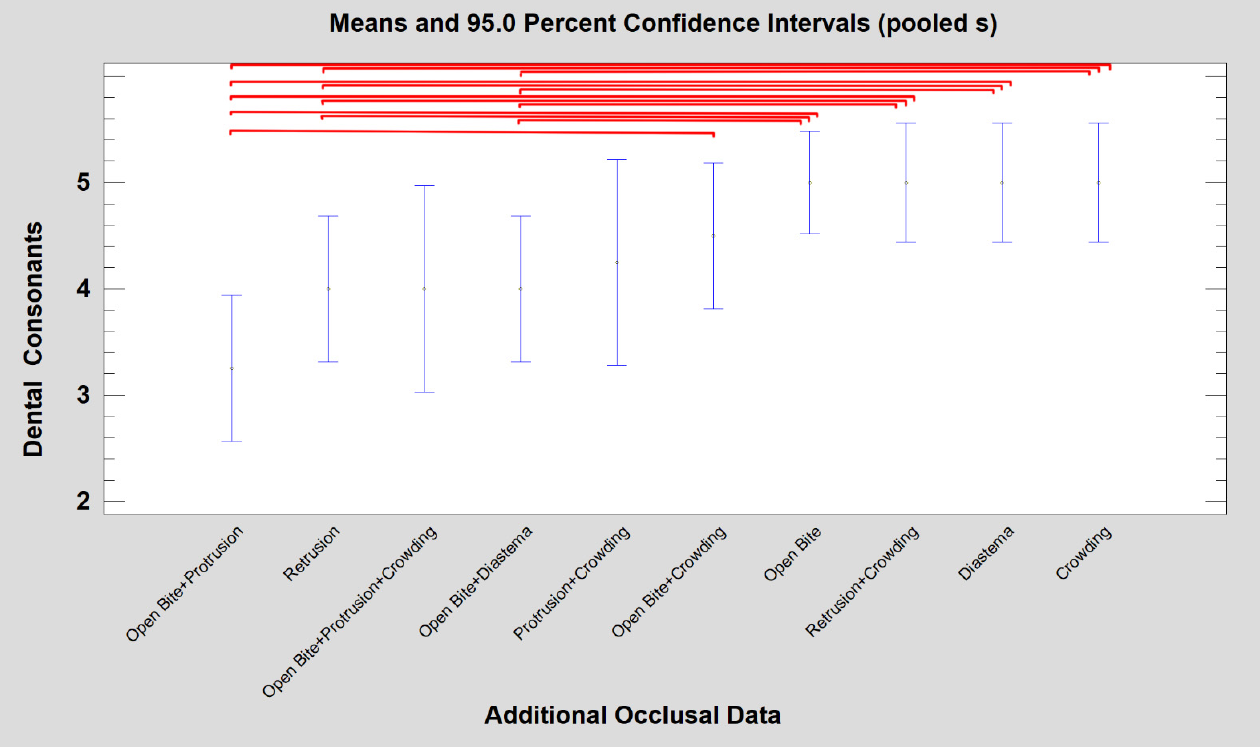
Figure 2. Final dental consonant pronunciation results in patients treated multimodally (higher scores, better speech). Quality of speech depends on specific dental positioning. These pairs show statistically significant differences at the 95.0% confidence level: Open Bite + Protrusion vs. Open Bite + Crowding, Open Bite + Protrusion vs. Open Bite, Open Bite + Protrusion vs. Retrusion + Crowding, Open Bite + Protrusion vs. Diastema, Open Bite + Protrusion vs. Crowding, Retrusion vs. Open Bite, Retrusion vs. Retrusion + Crowding, Retrusion vs. Diastema, Retrusion vs. Crowding, Open Bite + Diastema vs. Open Bite, Open Bite + Diastema vs. Retrusion + Crowding, Open Bite + Diastema vs. Diastema, and Open Bite + Diastema vs. Crowding ( p < 0.05). Red brackets indicate statistically significant differences ( p < 0.05).